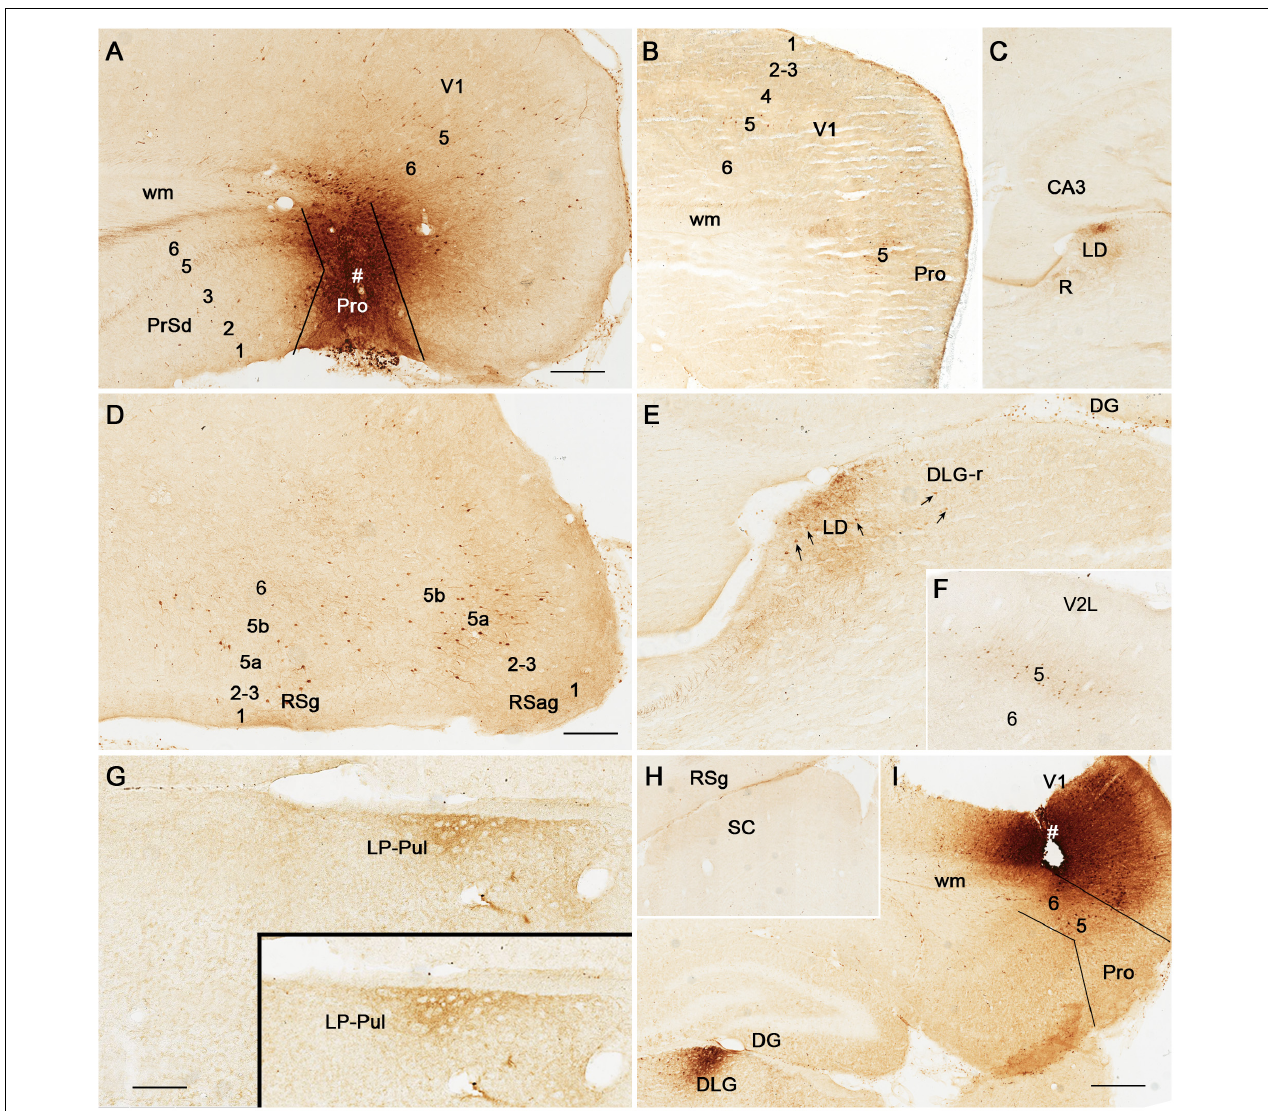
FIGURE 4 | Retrograde and anterograde tracing following a biotinylated dextran amine (BDA) injection in rat prostriata. All panels are from sagittal sections. The BDA injection (#) is restricted to the prostriata (Pro in A ). This injection resulted in both retrogradely labeled neurons and anterogradely labeled axon terminals. Labeled neurons are found in layer 5 of V1 and Pro (B) , layer 5 (5a and 5b) of the granular (RSg) and agranular (RSag) retrosplenial cortices (D) , and LD and DLG-r (E) as well as in layer 5 of the lateral secondary visual cortex (V2L in F ). Some labeled neurons in LD and DLG-r are indicated by the arrows in (E) . Labeled axon terminals are seen in layer 5 of PrSd and layer 6 of V1 (A) , LD and R (C,E) , layer 6 of RSg and RSag (D) , and the LP-Pul ( G ; with higher power view in the inset). Note that no retrogradely labeled neurons exist in LP-Pul. In the superior colliculus (SC), both labeled neurons and axon terminals are not detected (H) . As a control, following a BDA injection in the deep layers of V1 (# in I ), dense terminal labeling is seen in the DLG (I) , while some labeled neurons are observed in layer 5 of the prostriata (Pro in I ). In contrast, the BDA injection restricted in the prostriata (A) results in few terminal labeling in the DLG (E) . Bars: 300 µ m (A) for (A–C,F,H) ; 225 µ m (D) for (D,E) ; 200 µ m (G) ; 350 µ m (I)